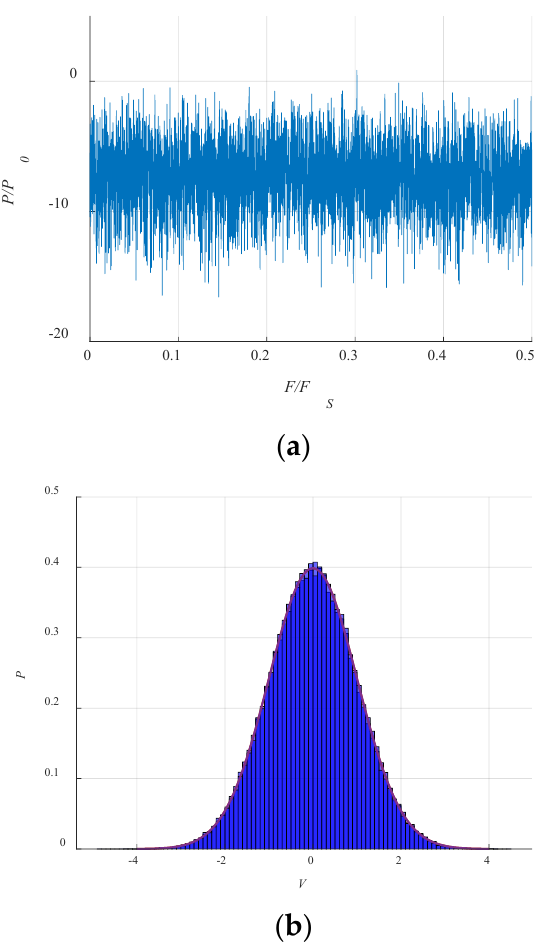
Figure 5. ( a ) Power spectrum of the random signal before the filtering; ( b ) Instantaneous amplitude distribution.